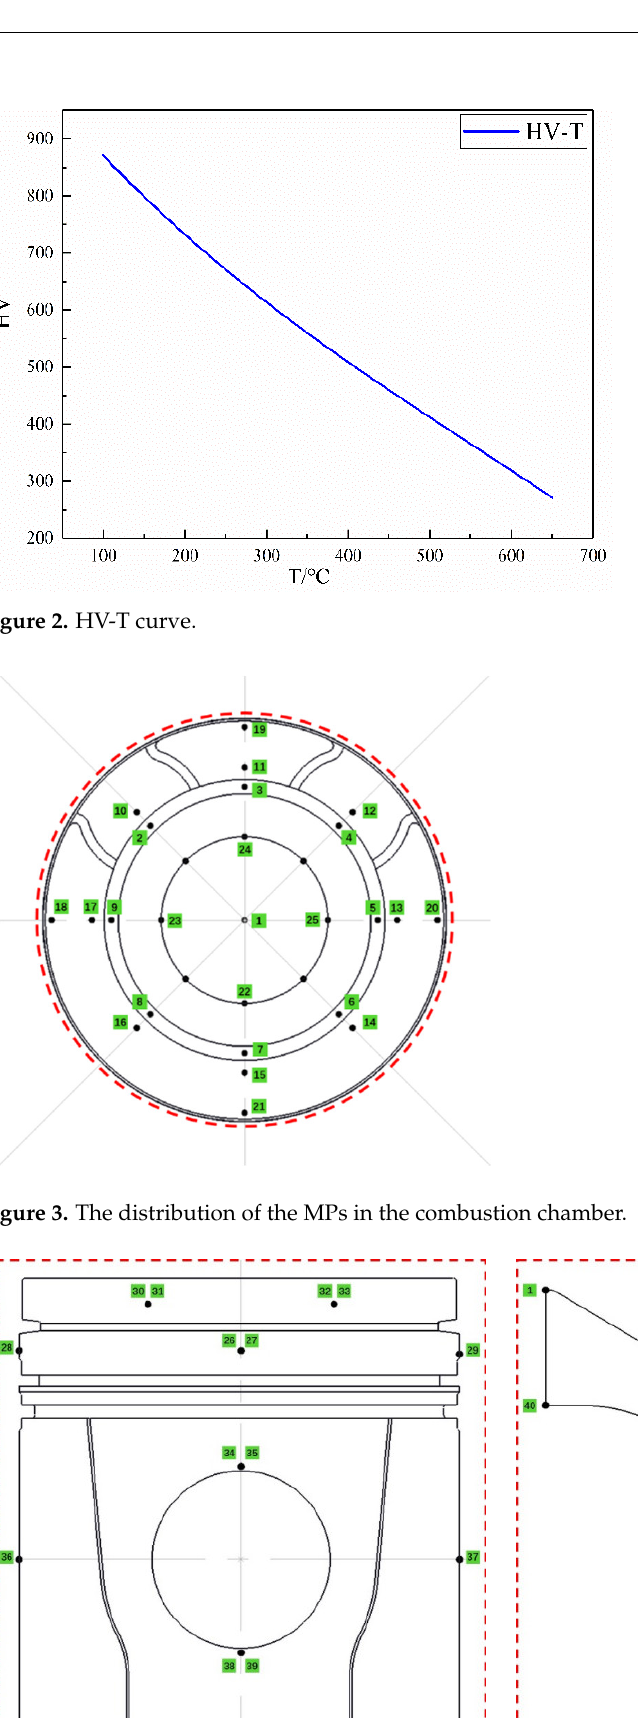
Figure 4. The distribution of the MPs on the other side.